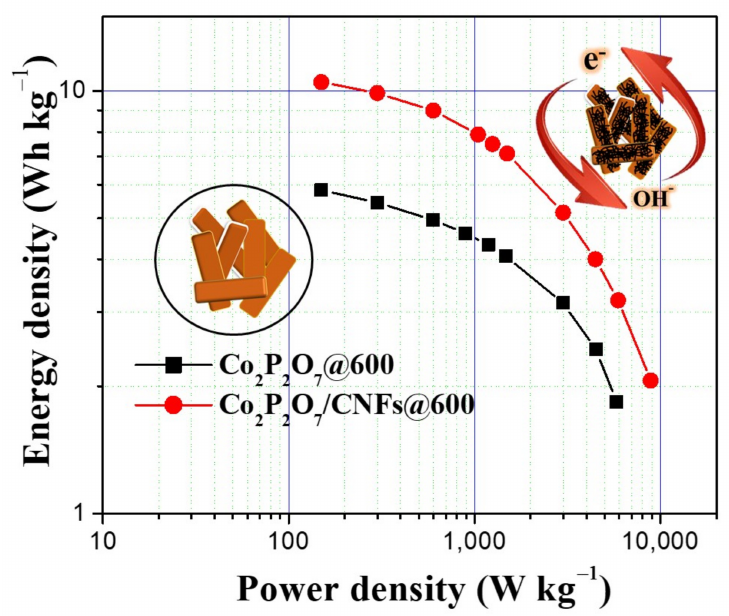
Figure 13. Ragone plot of energy density and power density of Co 2 P 2 O 7 /CNFs@600 compared to Co 2 P 2 O 7